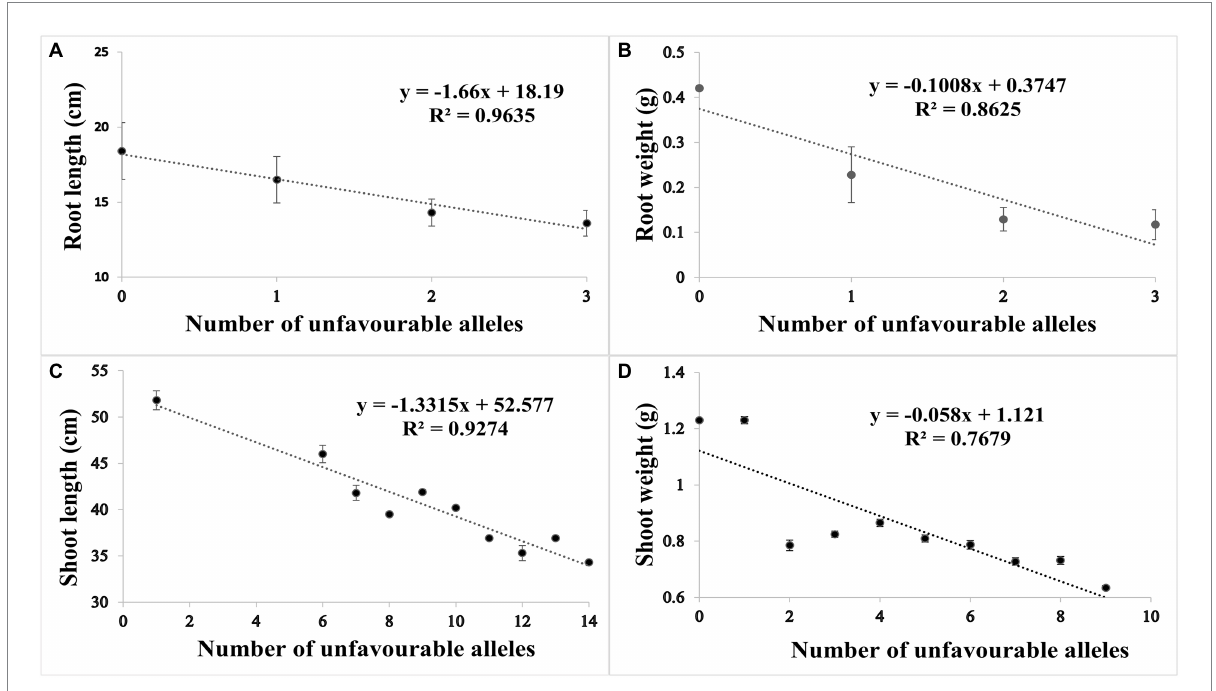
FIGURE 6 Scatter plots showing the effect of unfavorable alleles in (A) root length, (B) root weight, (C) shoot length and (D) shoot weight in